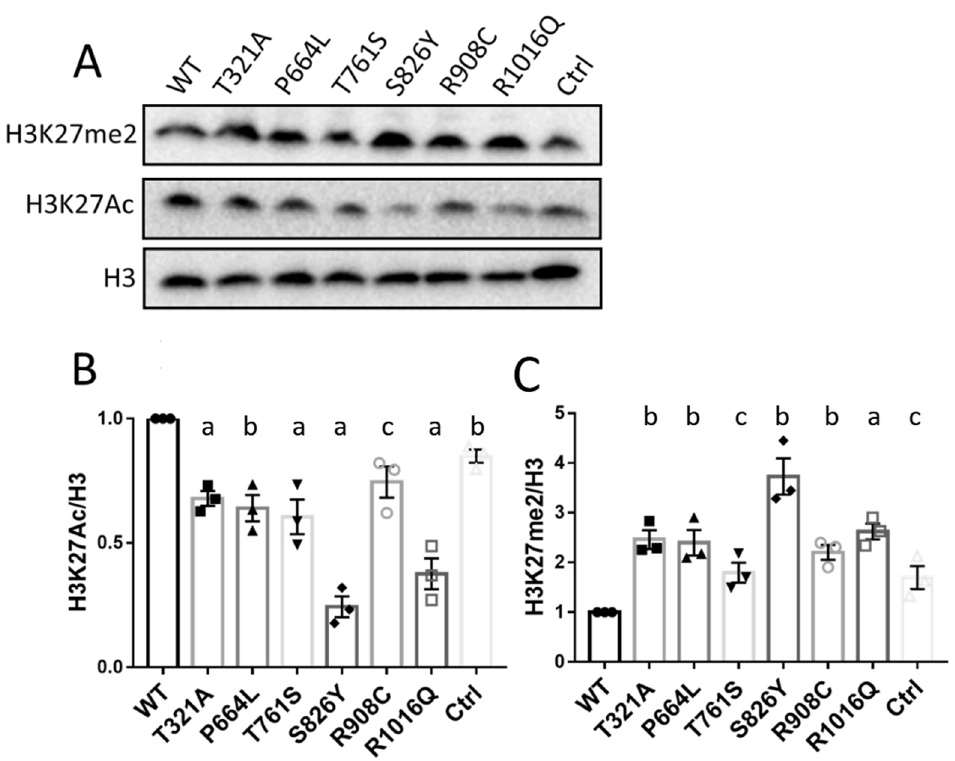
Figure 4. Overexpression of KDM6B mutants affected H3K27 demethylation and acetylation in HeLa cells. ( A ) HeLa cells were transfected with mutated and wild-type constructs of Flag-tagged KDM6B and pcDNA3.1 backbone vector for 48 h, and Western blotting was performed to quantify H3K27me2 and H3K27Ac protein levels in each group. H3 was used as loading control. ( B , C ) Western blotting was repeated three times and a Student t -test was performed to compare protein levels between wild-type and mutant of H3K27me2 and H3K27Ac, respectively. Significance compared to WT: “a” represents p < 0.001; “b” represents p < 0.01; “c” represents p < 0.05.